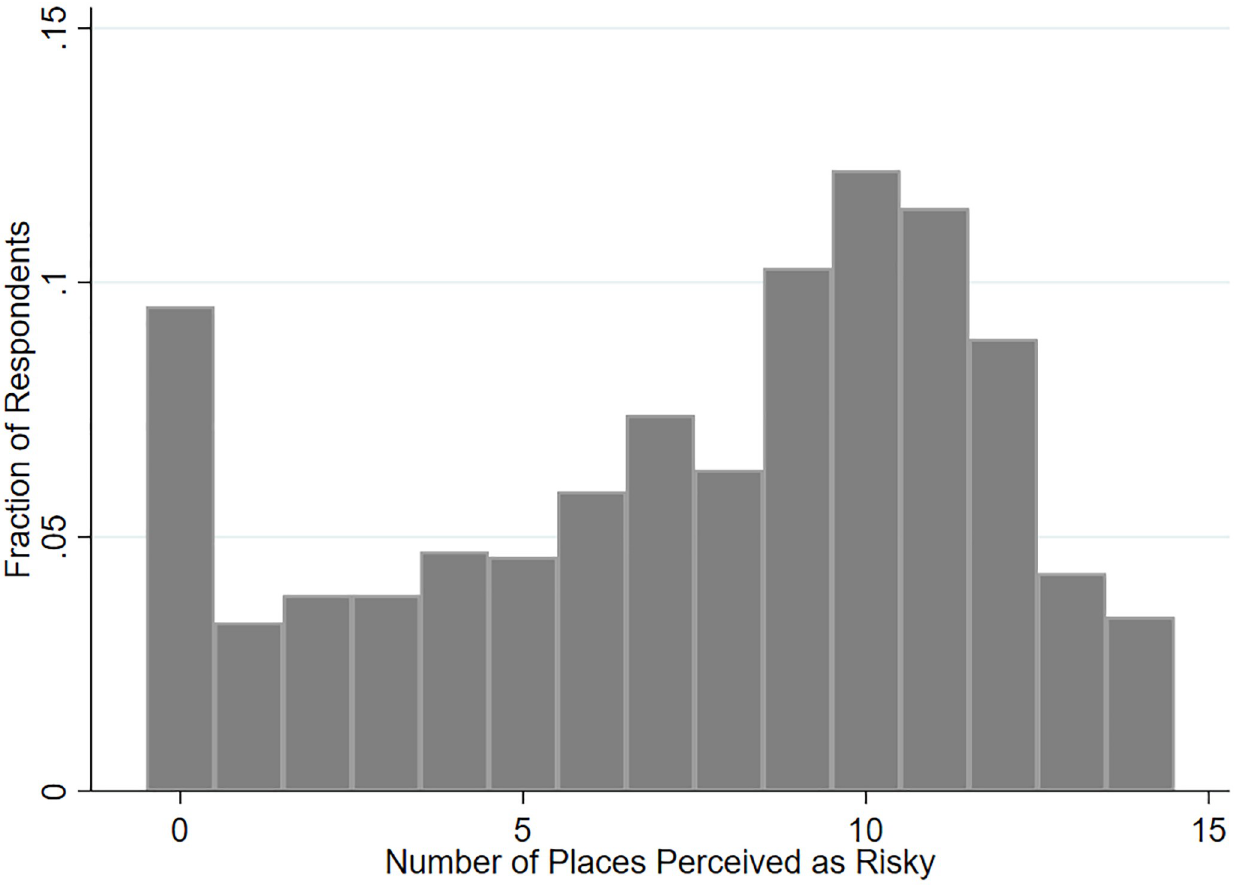
Fig 2. Histogram of the number of places people perceive as risky. The number of places respondents perceive as having positive risk (i.e., selected “somewhat risky” or “extremely risky”) was calculated. The fraction of individuals who perceive positive risk for different numbers of places is reported in the